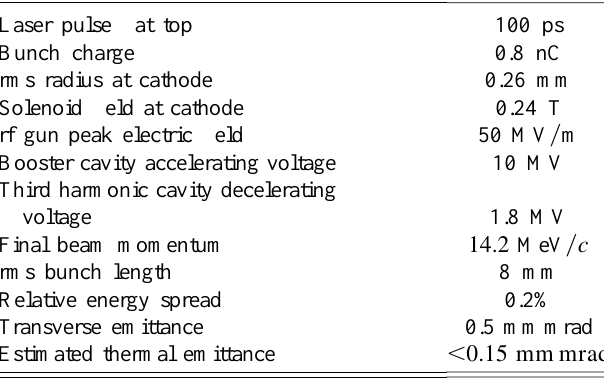
TABLE II. Electron source parameters.